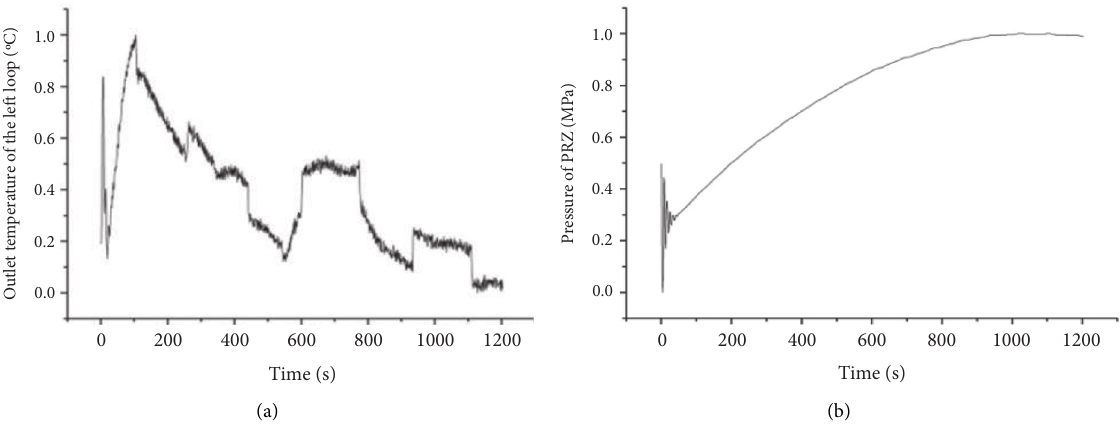
Figure 8: The curves of the parameters after